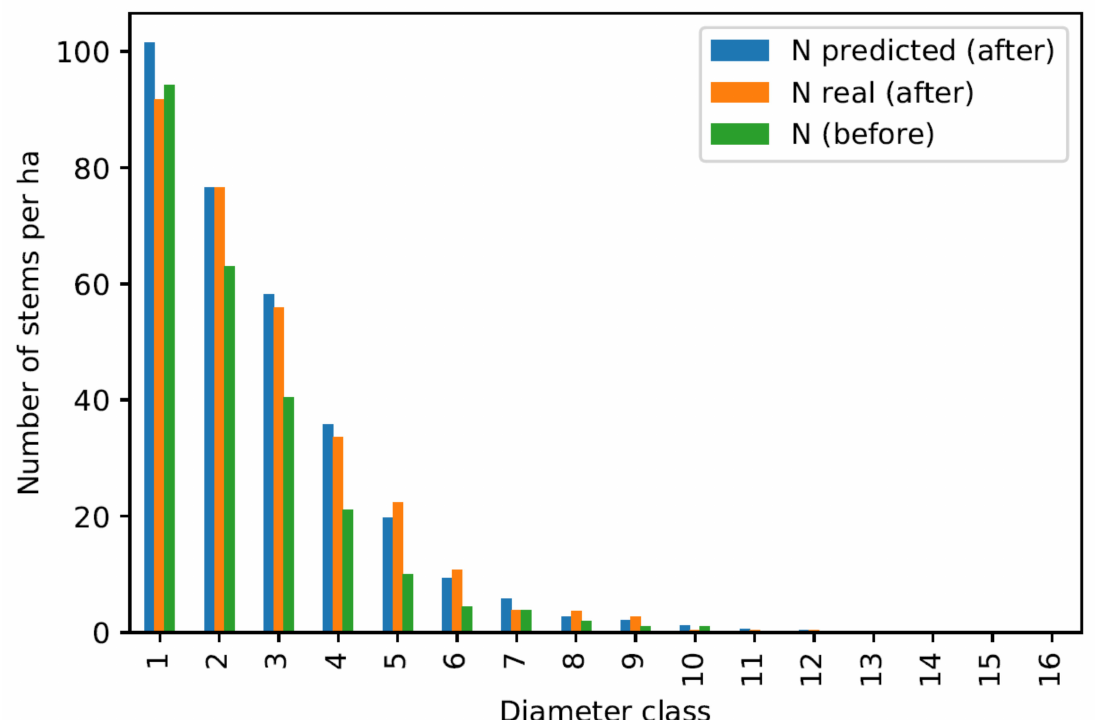
Figure 9. Overall prediction quality control for the division 2240 inventoried in the year